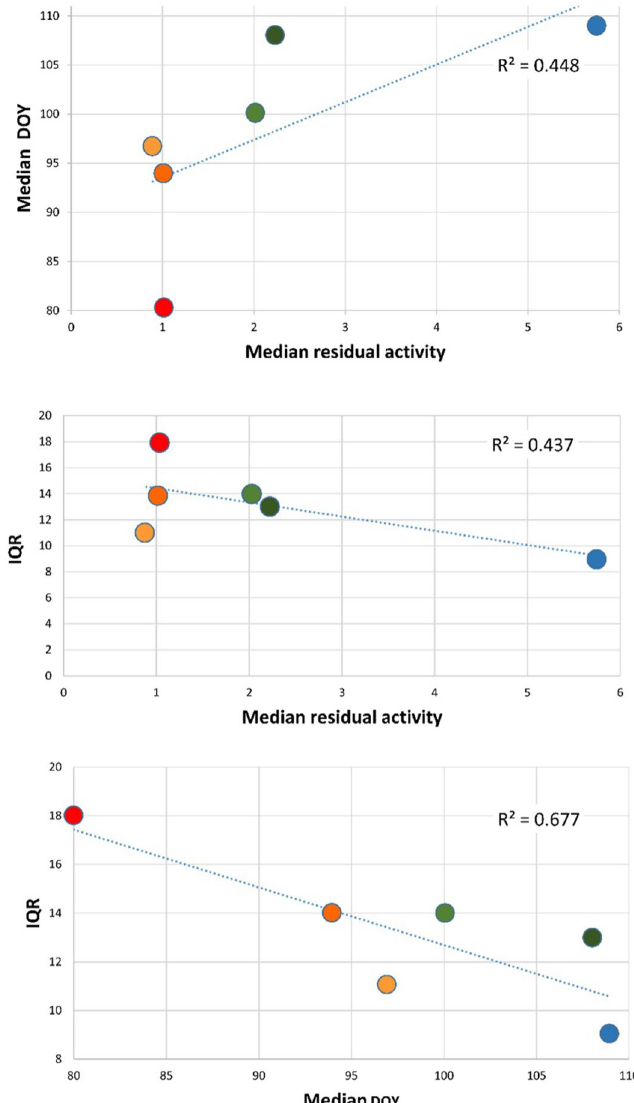
Figure 4. Relation between mean residual activity, median DOY of emergence and the interquartile range (IQR) of emergence activity; colors according to Fig.